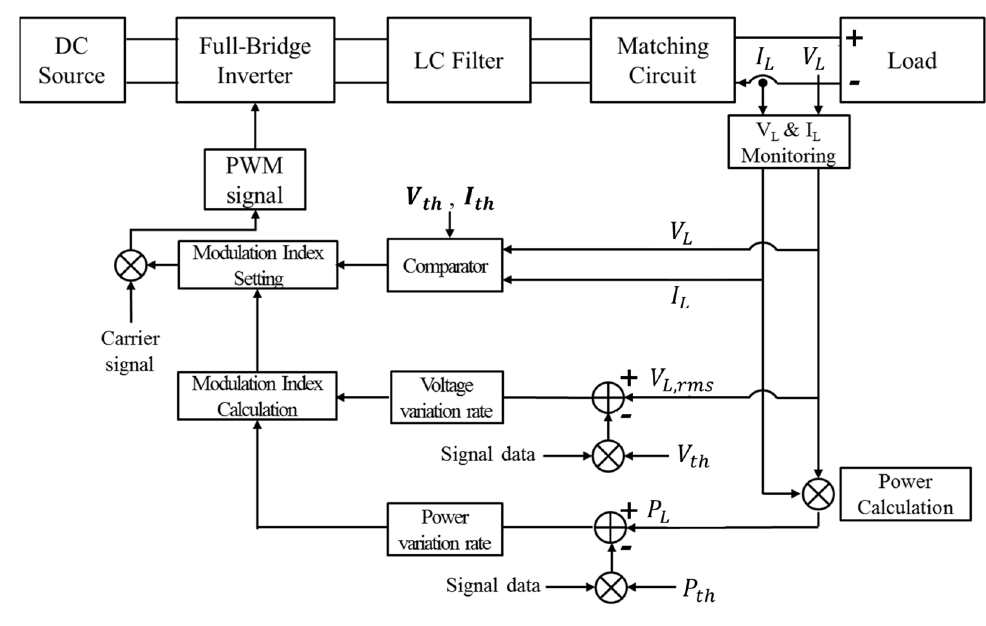
Figure 6. The proposed control block diagram of the transmitter.